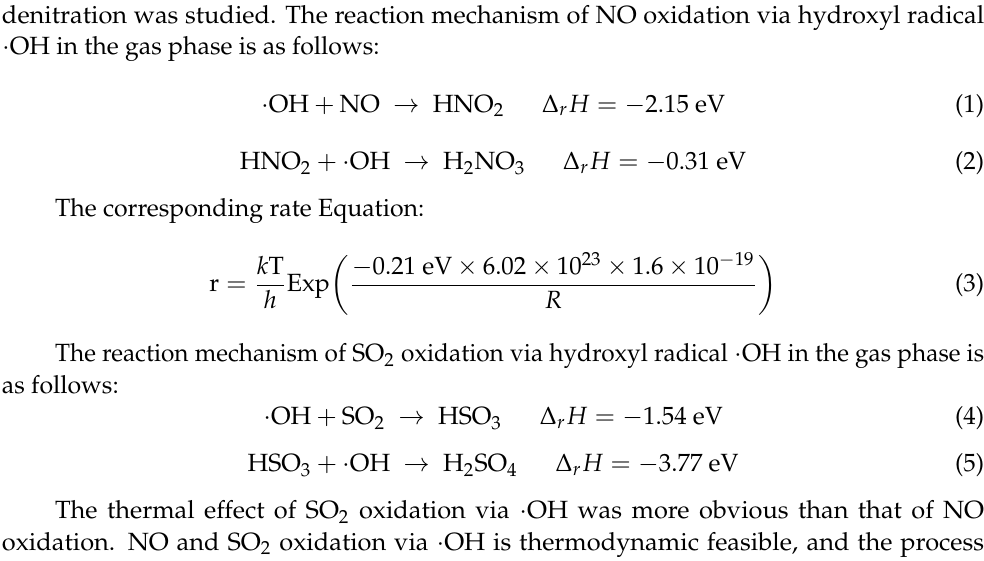
Adsorption Energy